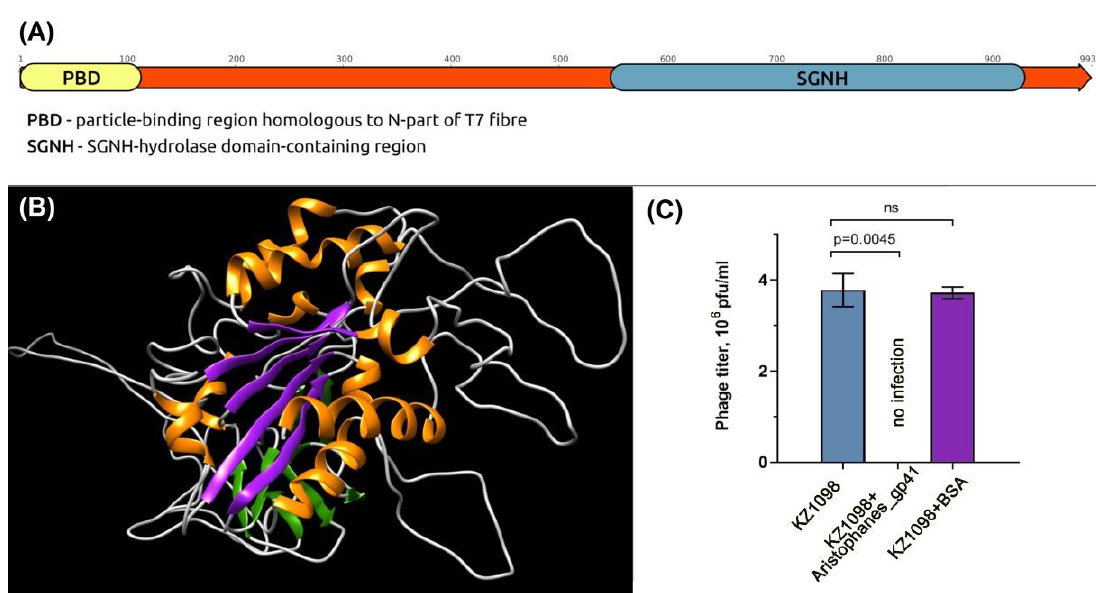
Figure 6. ( A ) Schematic representation of the Acinetobacter phage Aristophanes tailspike protein obtained with BLAST search and HMM analysis. ( B ) 3D structure homology modelling of the SGNH-hydrolase domain-containing region of the Acinetobacter phage Aristophanes tailspike protein obtained with HHpred. Five parallel β -sheets intrinsic for all SGNH-hydrolases are colored purple, other β -sheets are colored green and the α -helices are colored orange. The model is made using the PDB structure 4K7J of peptidoglycan O-acetylesterase belonging to SGNH-family. ( C ) Phage Aristophanes infection inhibition by Aristophanes_gp41. From left to right, phage titers observed on the bacterial lawns after the treatment of A. baumannii KZ1098 cells with phage Aristophanes only, after cell cultures preincubated with purified Aristophanes_gp41, and BSA (as a negative control), followed by phage Aristophanes treatment. P: p -value, ns: not significant.